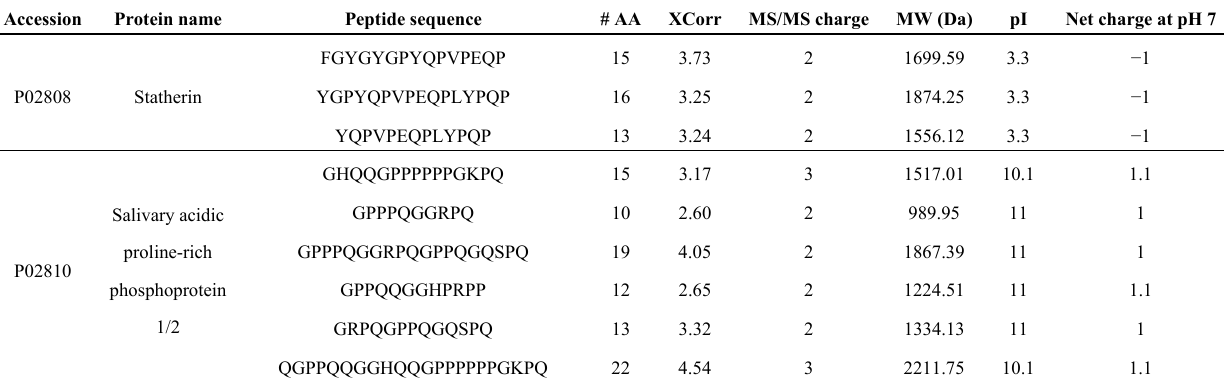
Table 2. Identified naturally occurring peptides from in vivo AEP originating from deciduous enamel